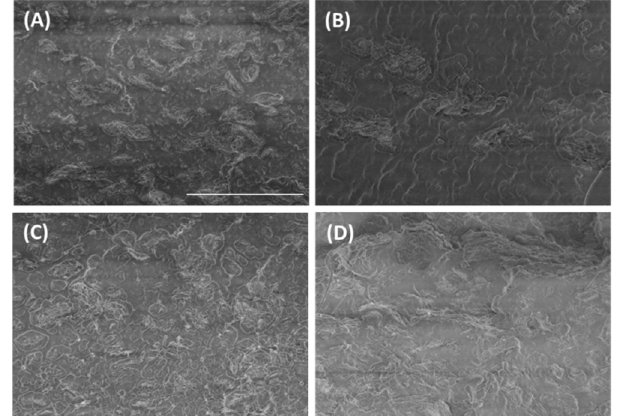
Figure 1. SEM images of ( A ) G1M, ( B ) G1S, ( C ) GPE1M, ( D ) GPE3M. The scale bar applies for all samples and corresponds to 10 µm.